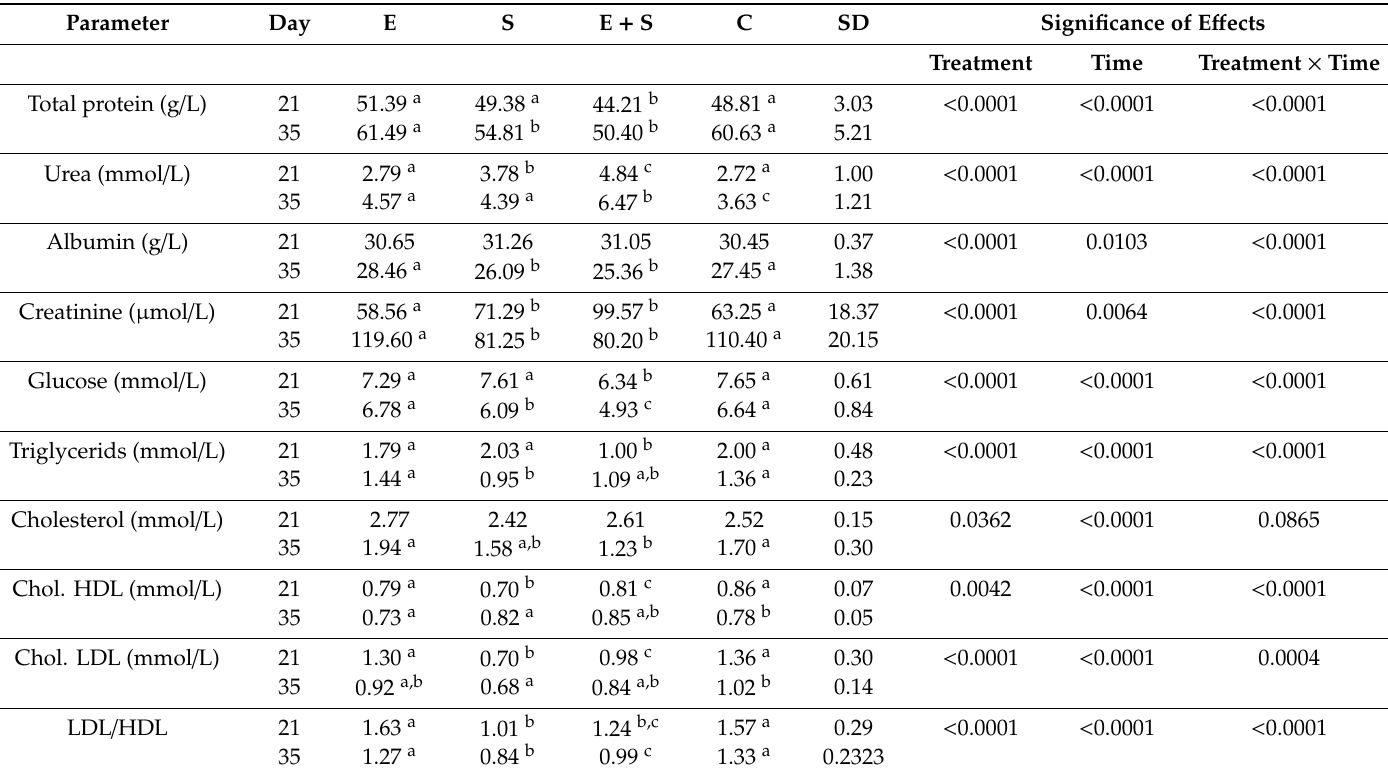
Table 4. The e ff ect of E, S, and E + S dietary supplementation on the blood enzymatic and mineral profile of